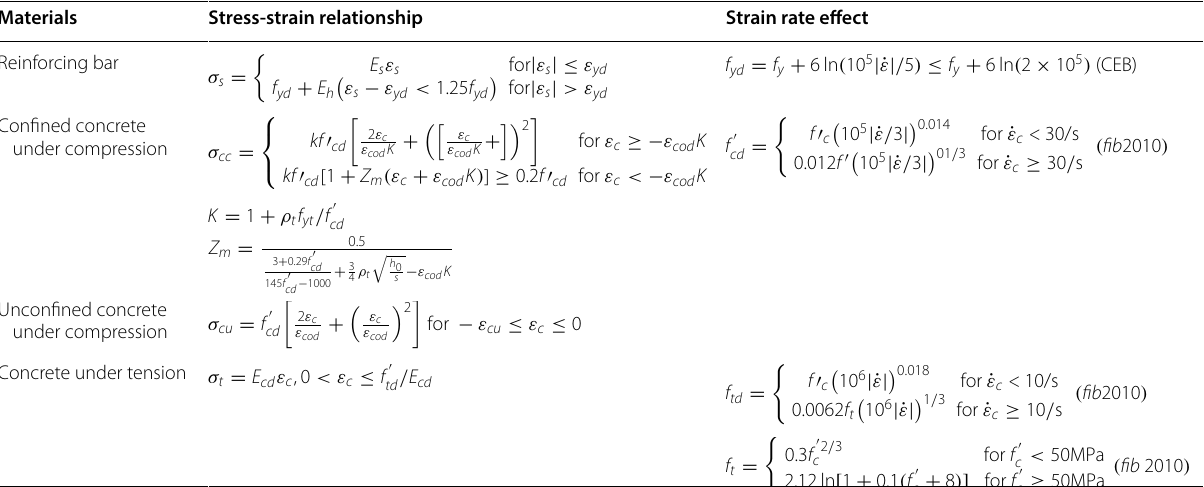
σ s , reinforcing bar stress; f yd and f y , dynamic and static yield strength of reinforcing bar; ε yd , dynamic yield strain of reinforcing bar; E s and E h , elastic and strain hardening moduli ( E h 0.01 E s ); σ cc and σ cu , stress of confined concrete and unconfined concrete in compression; f ′ cd and f ′ c , dynamic and static compressive strength = ε co ( 10 5 ˙ ε c / 3 ) 0.02 and 0.0006 + 0.005ln ( f ′ c ) , respectively) ( fib 2010); f yt , yield strength of transverse bars; ρ t , of concrete; ε cod and ε co , dynamic and static peak strain ( = volumetric ratio of transverse bars ( = 2 A t ( h ix + h iy )/( h ox h oy s ) ); A t , sectional area of transverse bars; h ix and h iy , center-to-center distances of transverse bars in x- and y- directions; h ox and h oy , outer distances of transverse bars in x- and y-directions; and s , spacing of transverse bars; ε cu , ultimate compressive strain corresponding to 0.2 f ′ = 21500 3 f ′ c / 10 and E c ( 10 6 ˙ ε c ) 0.026 , respectively) ( fib 2010); f td and cd (Scott et al. 1982); σ t , concrete stress in tension; E c and E cd , static and dynamic elastic modulus ( f t , dynamic and static tensile strength of concrete. (cid:31)